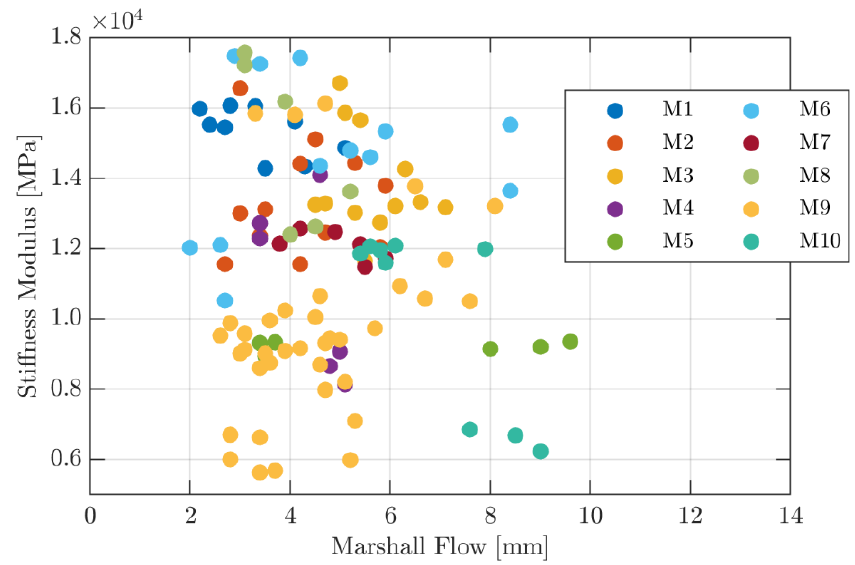
Figure 2. Scatter plot between Stiffness Modulus and Marshall Flow.